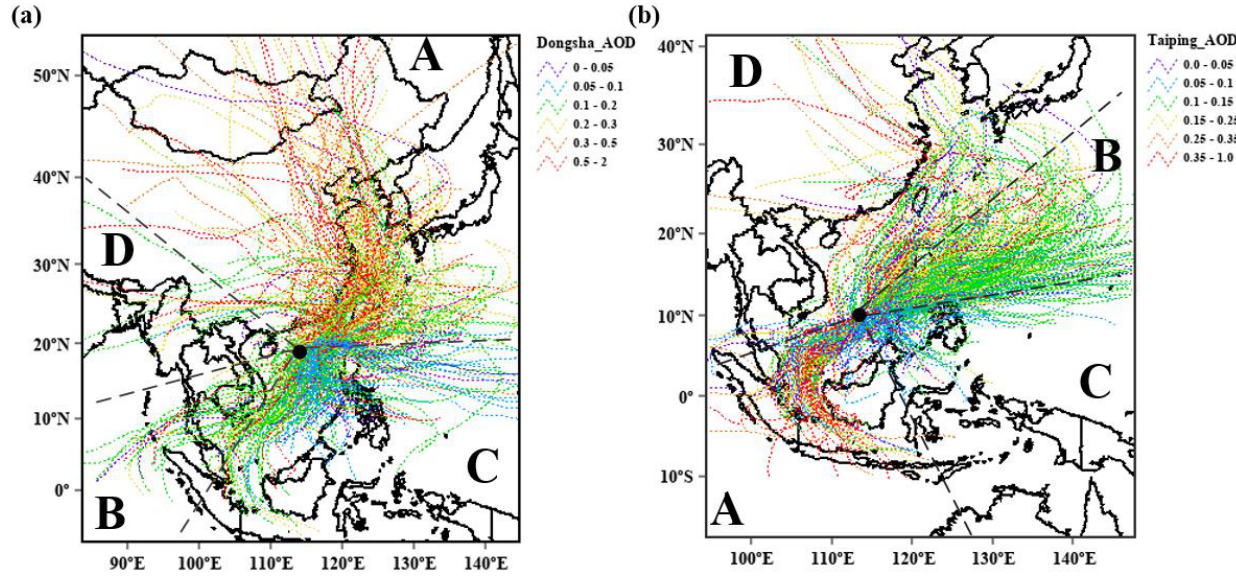
Figure 8. Five-day trajectories ending at 500 m from January 2018 to January 2021 at ( a ) Dongsha and ( b ) Taiping; The color of the trajectory represents the value of aerosol optical depth. One trajectory per day was displayed; The different source areas are separated into four sections (A, B, C and D), as shown in the panel.